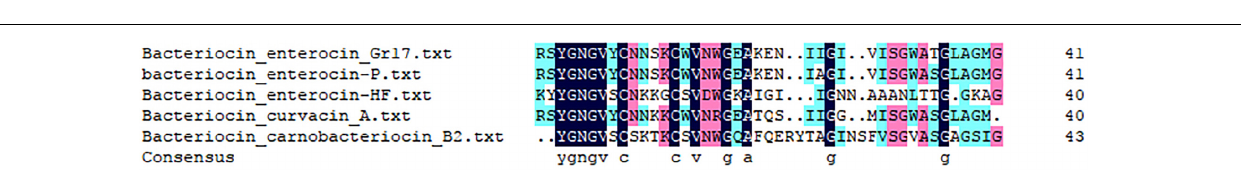
FIGURE 3 | Purification of enterocin Gr17 from E. faecalis Gr17 by column chromatography. (A) Cation exchange column. (B) Gel filtration chromatography. (C) RP-HPLC. (D) Mass spectrum of enterocin Gr17 by MALDI–TOF–MS. a, process of purification; b, antibacterial activity of peaks against indicator strain by agar well diffusion assay; c, tricine–SDS–PAGE of activity fraction.